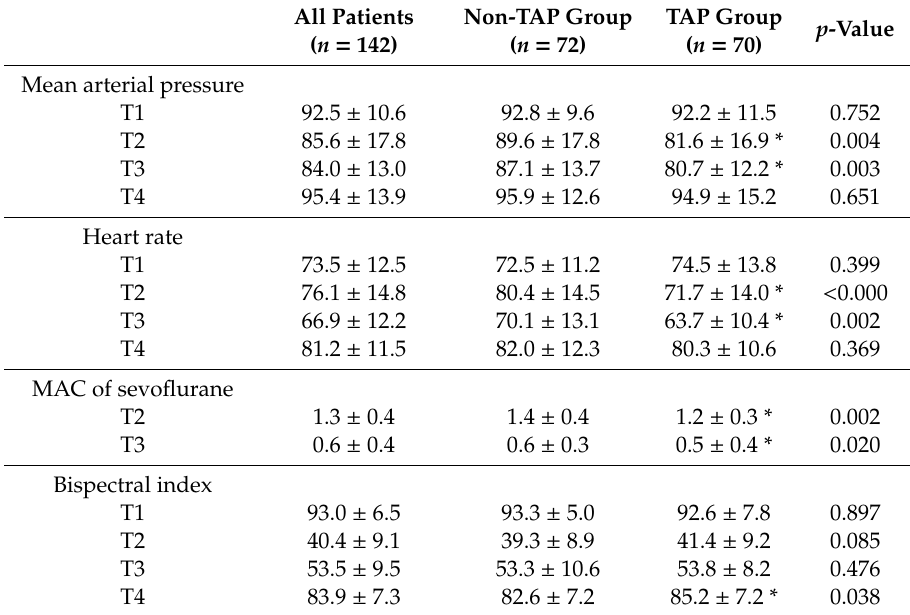
Table 2. Intraoperative vital signs, minimum alveolar concentration, and bispectral index over time. All